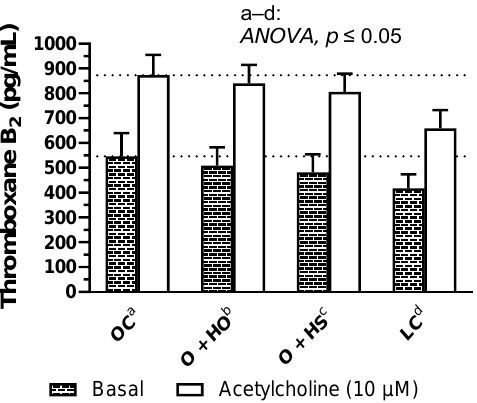
Figure 7. Basal- and acetylcholine-induced TXA 2 release from thoracic arteries of 8-week-old lean (LC) and obese (OC) Zucker rats fed a diet containing hemp seed oil (HO) and hemp seeds (HS) for 4 weeks. Values are means ± SD, n = 6, p ≤ 0.05 (two-way ANOVA). HO and HS had no influence on basal and acetylcholine-induced TxA 2 release in arteries.